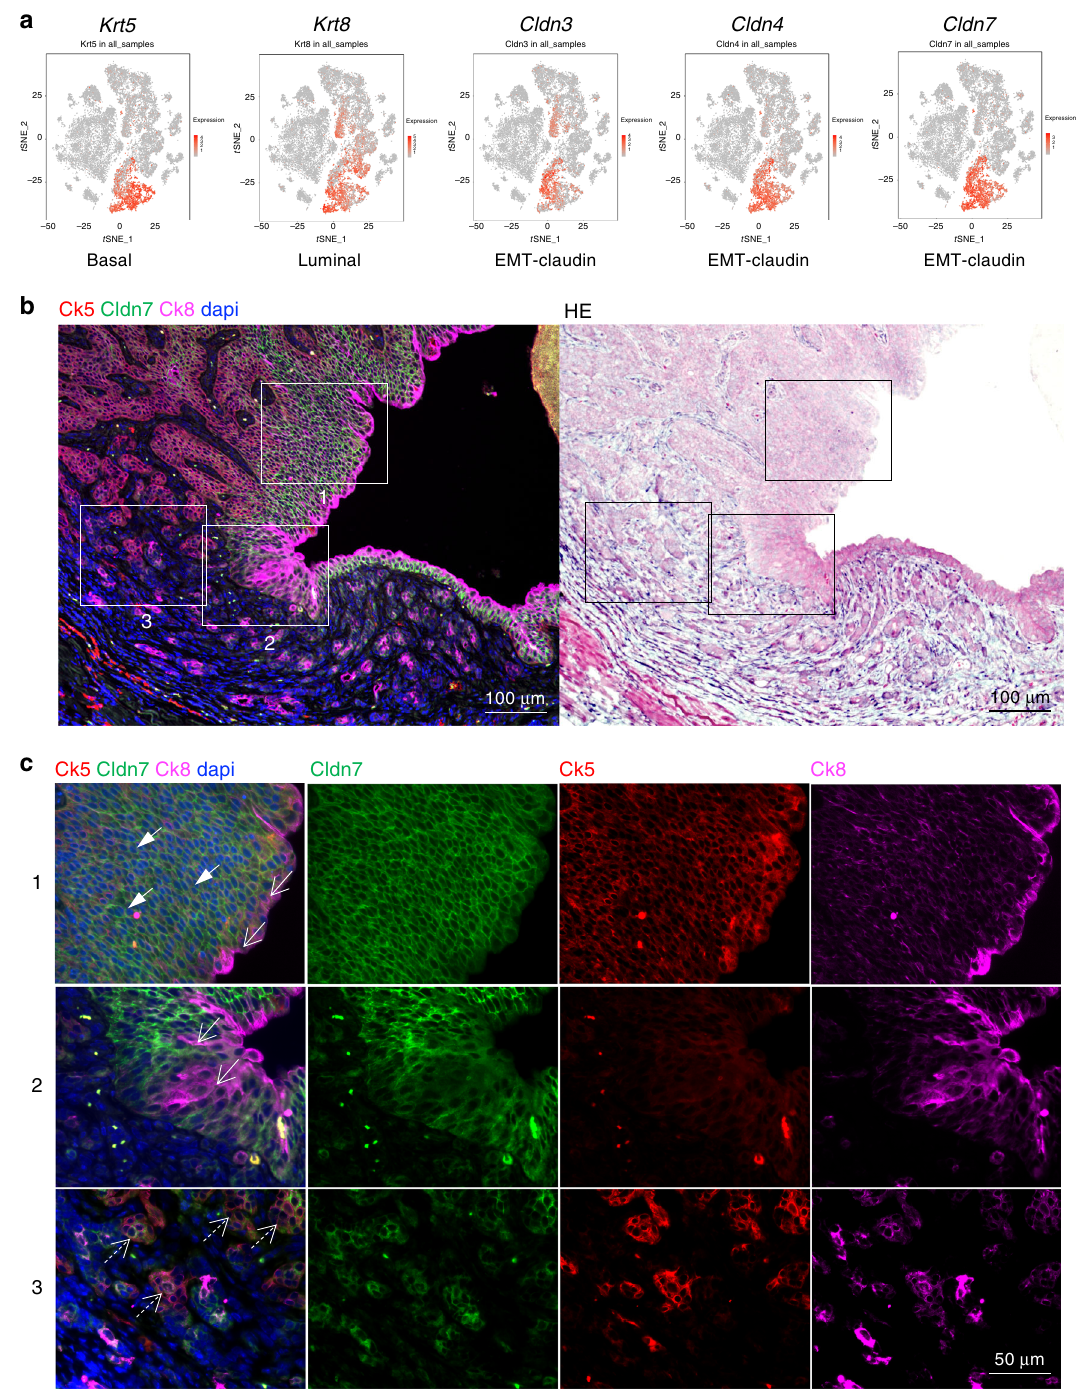
Fig. 2 Detection of OHBBN-induced bladder cancer cells with single-, double-, and triple-lineage marker-positive cells. a Single-cell RNA-seq analysis showing the presence of epithelial cells high in basal ( Krt5 ), luminal ( Krt8 ), and EMT-claudin ( Cldn3 , Cldn4 , and Cldn7 ) marker gene expression. b Low- magni fi cation triple immuno fl uorescence detection of Ck5 ( Krt5 ), Ck8 ( Krt8 ), and Cldn7 ( Cldn7 ), and the corresponding hemotoxylin & eosin (re-stain of IF slide). c High-magni fi cation views of insets from b showing instances of tumor cells co-expressing Ck5-Cldn7-Ck8 low (solid arrows), Ck8 hi -Cldn7 (open arrows), and Ck5-Cldn7-Ck8 (open dashed arrows). Each experiment was performed at least in Immune (Saa3), and luminal ( Gpx2 and Upk2 ) shown together OHBBN tumors to cluster into several subtypes. To compare (Supplementary Fig. 11B) or as independent lineages (Supple- lineage pathways in the tumor samples analyzed, we calculated mentary Fig. 11C). Thus, using a second expression analysis and plotted z -scores to identify outlier genes for each lineage approach, we have demonstrated that genes belonging to multiple (color and boxes) including basal ( Itga6 , Cd44 , and Col17a1), clinical mRNA subtypes can be concomitantly overexpressed in squamous ( Tgm1 ), luminal ( Gpx2 and Erbb2 ), EMT-claudin OHBBN-induced bladder tumors. ( Snail1 , Snail2 , Cldn7 ), Neuronal differentiation ( Sox2 and Chga ),